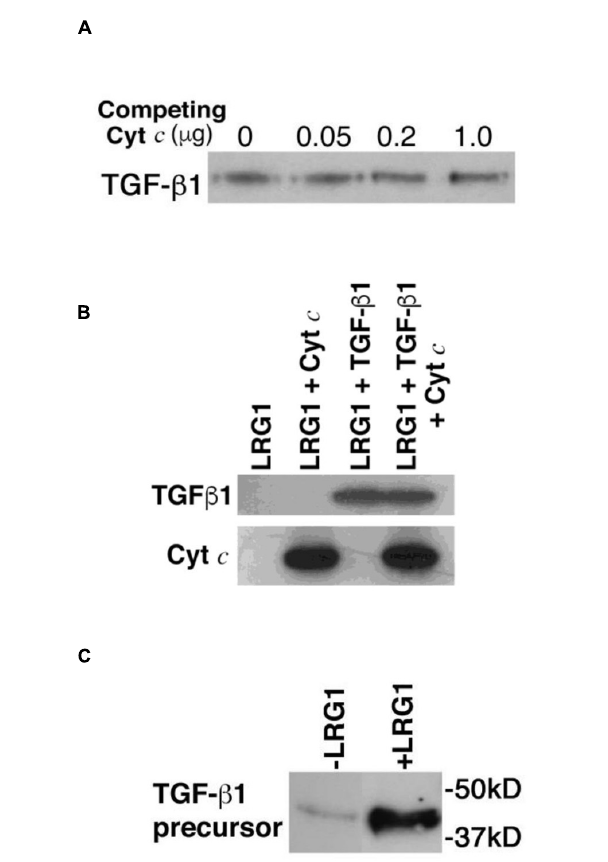
FIGURE 2 | Transforming growth factor-beta 1 and Cyt c bind LRG1 simultaneously. (A) Cyt c does not interfere with TGF- β 1 binding to